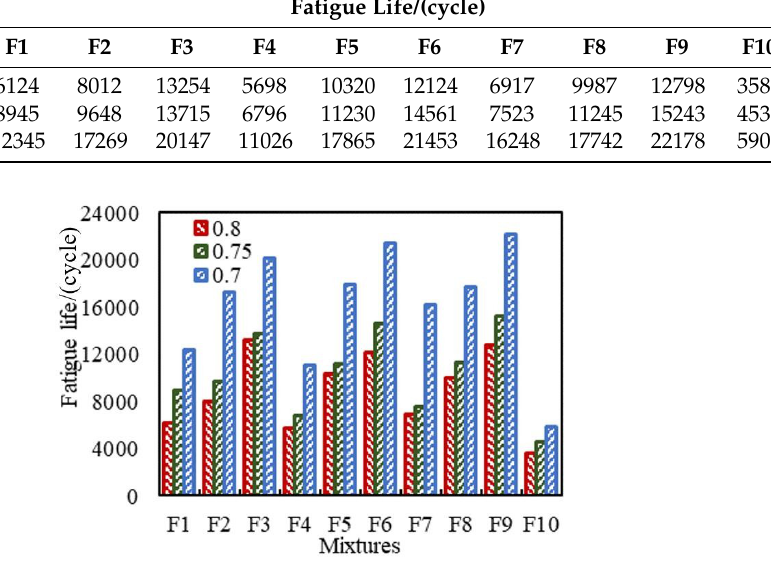
Figure 8. Curves of the fatigue life.